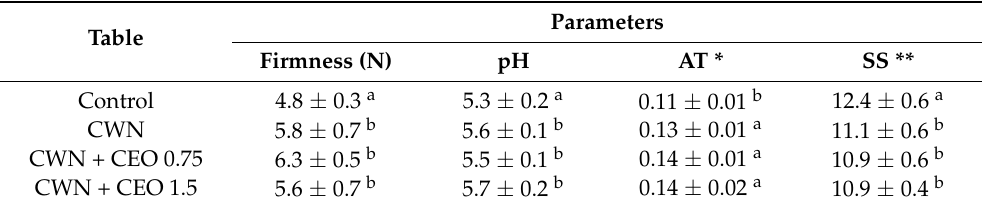
Table 1. Results of physicochemical parameters of papaya uncoated and coated during 12 days of storage (16 ± 1 ◦